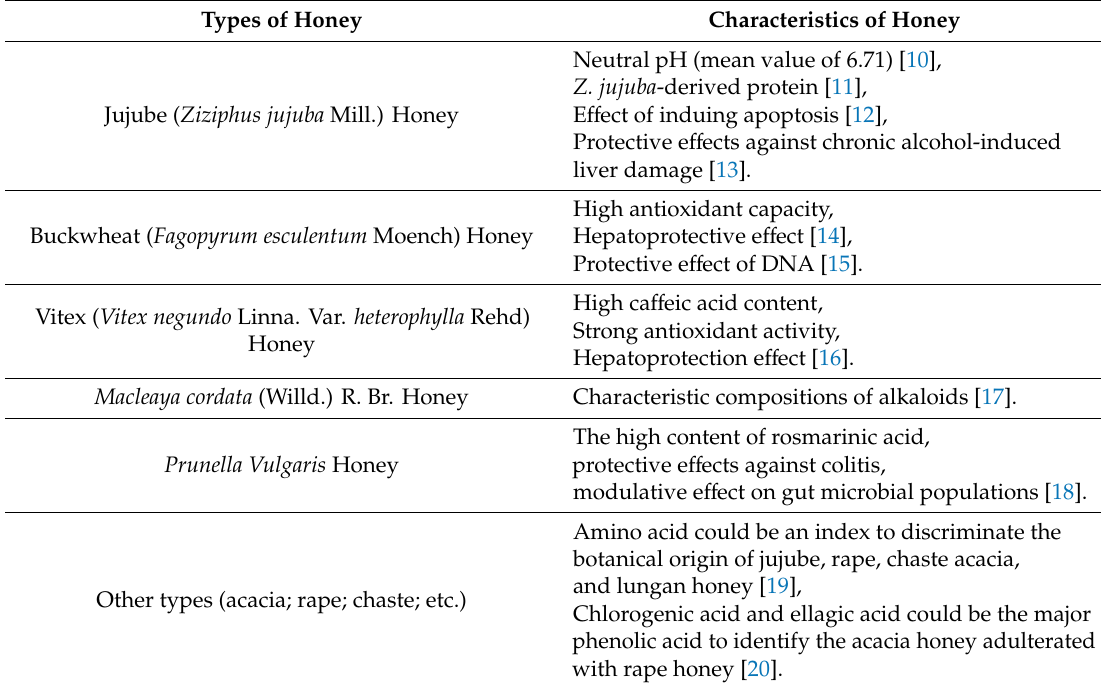
Table 1. List about di ff erent types of monofloral honey in China researched in the last 10 years. (Characteristic on physicochemical and biochemical properties as well as the therapeutic e ff ect). Types of Honey Characteristics of Honey Neutral pH (mean value of 6.71) [10], Jujube ( Ziziphus jujuba Mill.) Honey Protective e ff ects against chronic alcohol-induced liver damage